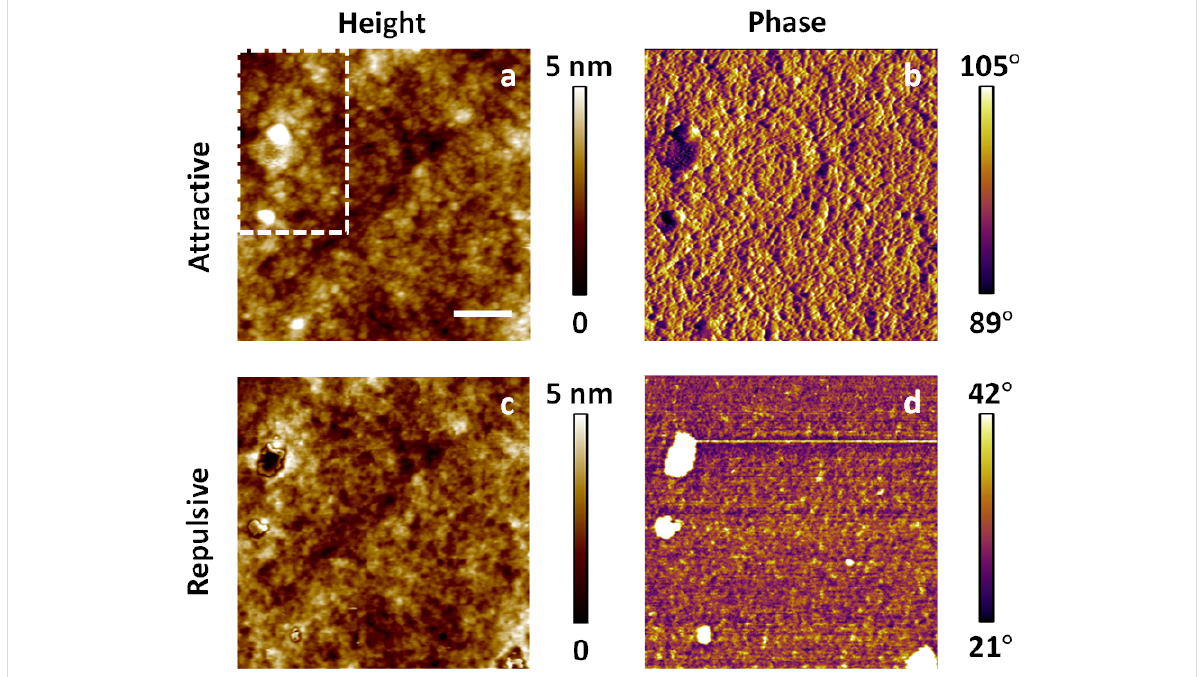
Figure 1: (a) and (b) topography and phase images, respectively, of a Nafion ® membrane acquired in the attractive regime; (c) and (d) corres- ponding images acquired in the repulsive regime. The scale bar is 100 nm. The morphology of the region in the dashed rectangle in (a) is discussed below in Figure 6. The free oscillation amplitude in both cases was 17 nm, with an amplitude setpoint of 80% for attractive regime imaging and 50% for repulsive regime imaging.